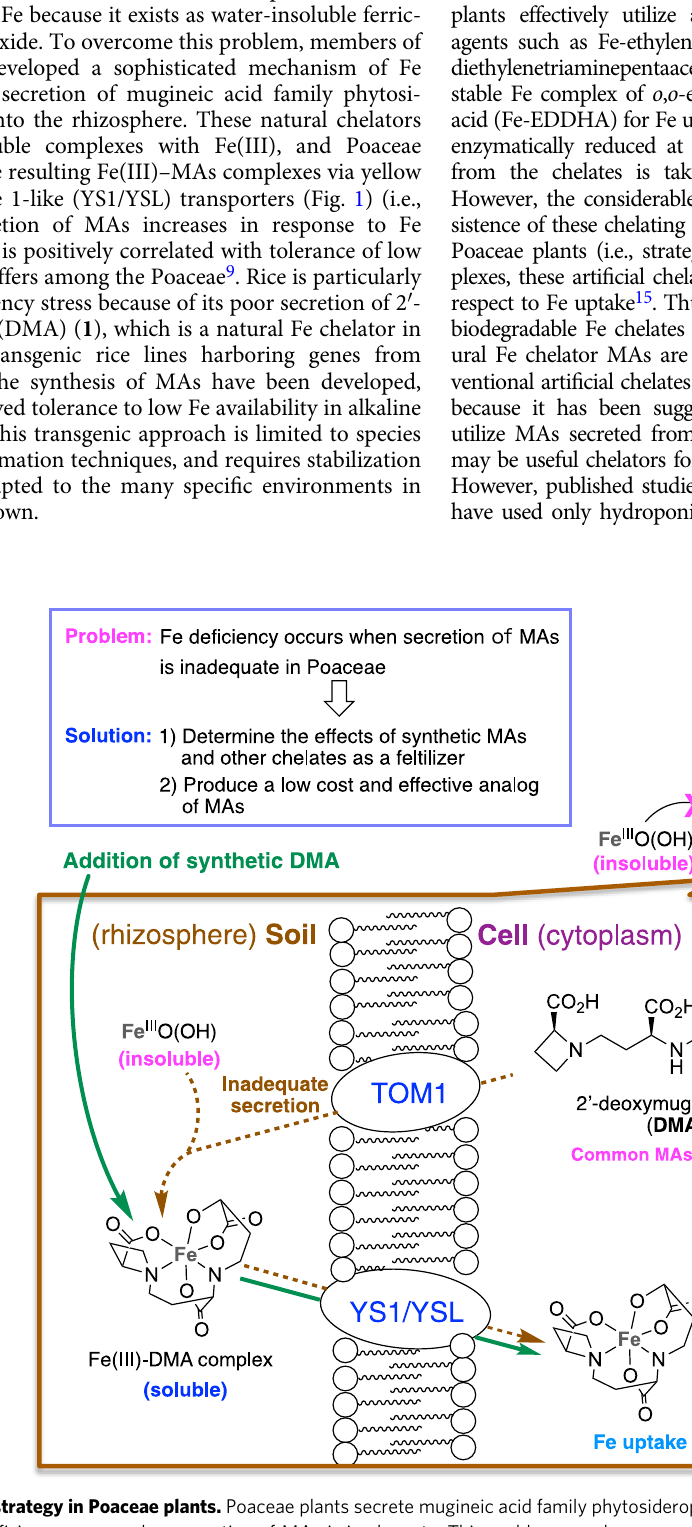
Fig. 1 Iron (Fe) uptake strategy in Poaceae plants. Poaceae plants secrete mugineic acid family phytosiderophores (MAs) into the rhizosphere and absorb Fe-MAs complex. Fe de fi ciency occurs when secretion of MAs is inadequate. This problem may be overcome by adding synthetic 2 ′ -deoxymugineic acid (DMA) or an analog thereof. DMA 2 ′ -deoxymugineic acid, MAs mugineic acids, TOM1 transporter of mugineic acid 1, YS1/YSL yellow stripe 1/yellow stripe 1 like